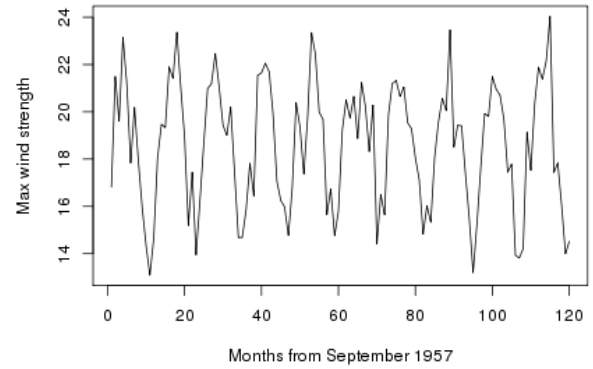
Fig. 2. Fitting a straight line to the raw data indicates a negative trend.